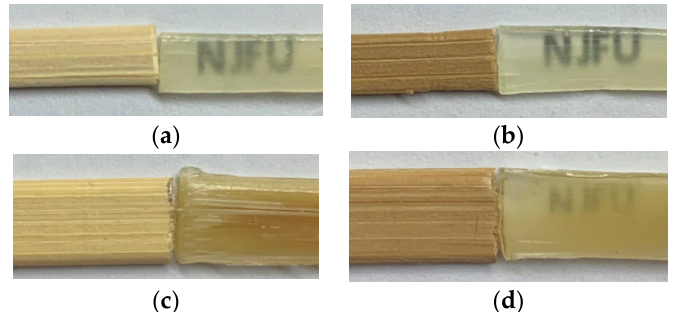
Figure 8. Photos of different types of bamboo material (left) and transparent bamboo (right). ( a ) IB and TIB; ( b ) HIB and THIB; ( c ) OB and TOB; ( d ) HOB and THOB).